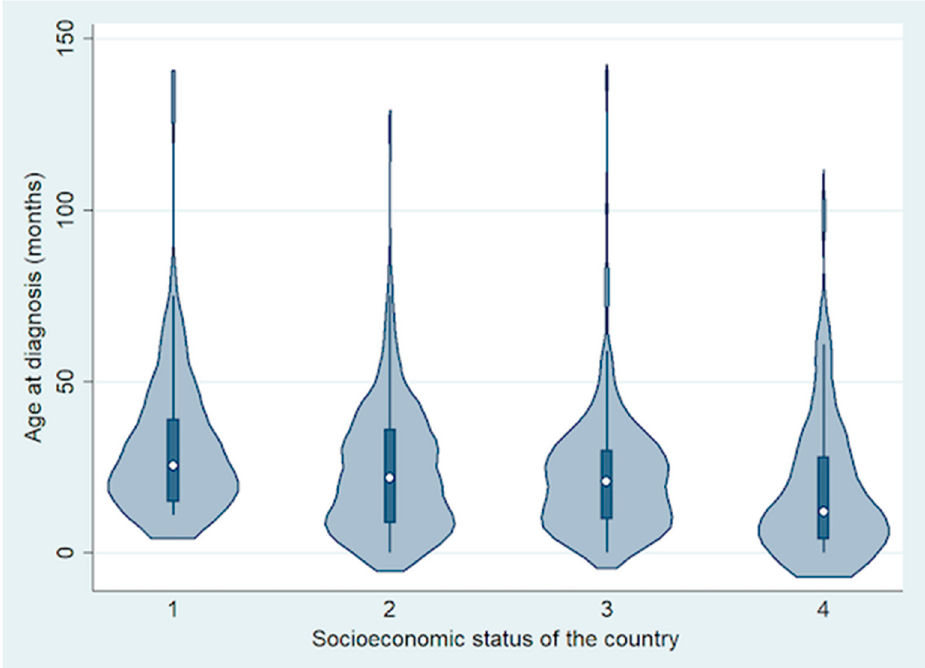
Figure 1. Violin plot showing the difference in age at diagnosis based on socioeconomic status of the country.